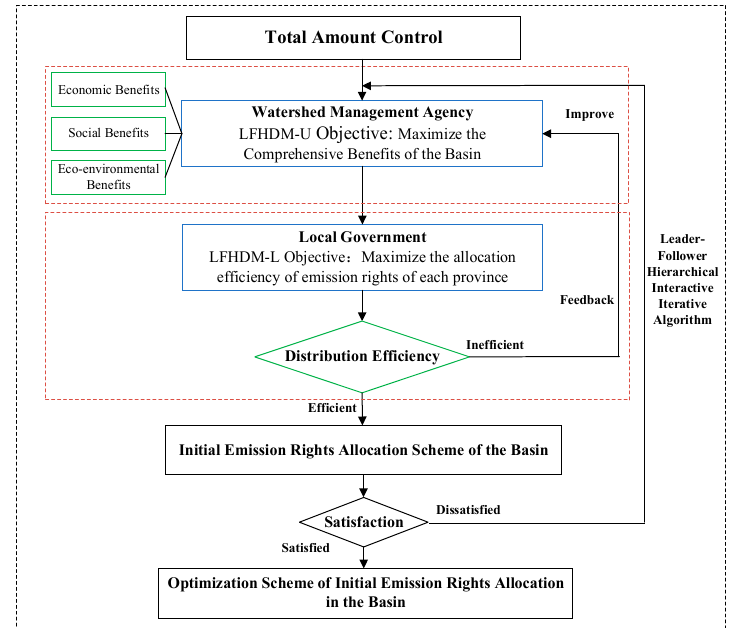
Figure 1. The framework of the